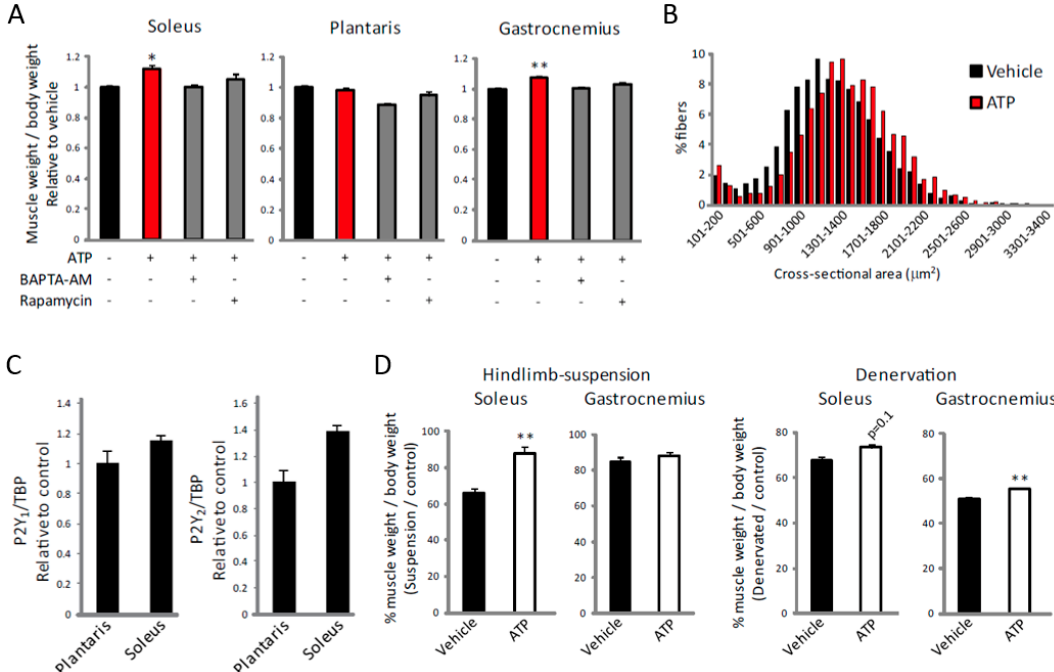
Figure 6. ATP induces muscle hypertrophy and alleviates muscle atrophy in an [Ca 2+ ] i - and mTOR-dependent manner. ( A ) Effects of ATP with or without BAPTA-AM or rapamycin on the increase of muscle weight in soleus, plantaris and gastrocnemius muscles ( n = 4). ( B ) The cross-sectional area distributions were plotted as frequency histograms. At least 2800 fibers from 4 different soleus muscles were counted. ( C ) Expression of P2Y 1 and P2Y 2 receptor mRNA in soleus and plantaris muscle ( n = 8). ( D ) Effects of ATP on soleus and gastrocnemius muscles weights in hindlimb-suspended (left) or denervated (right) muscle shown as a percentage of the control group ( n > 4). * p < 0.05, ** p < 0.01 by ANOVA with Tukey-Kramer test in ( A ), and ** p < 0.01 by Student’s t -test in ( D ). Error bars indicate S.E.M.